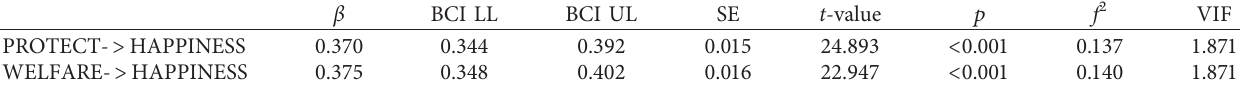
Table 7: SSI and HC path model